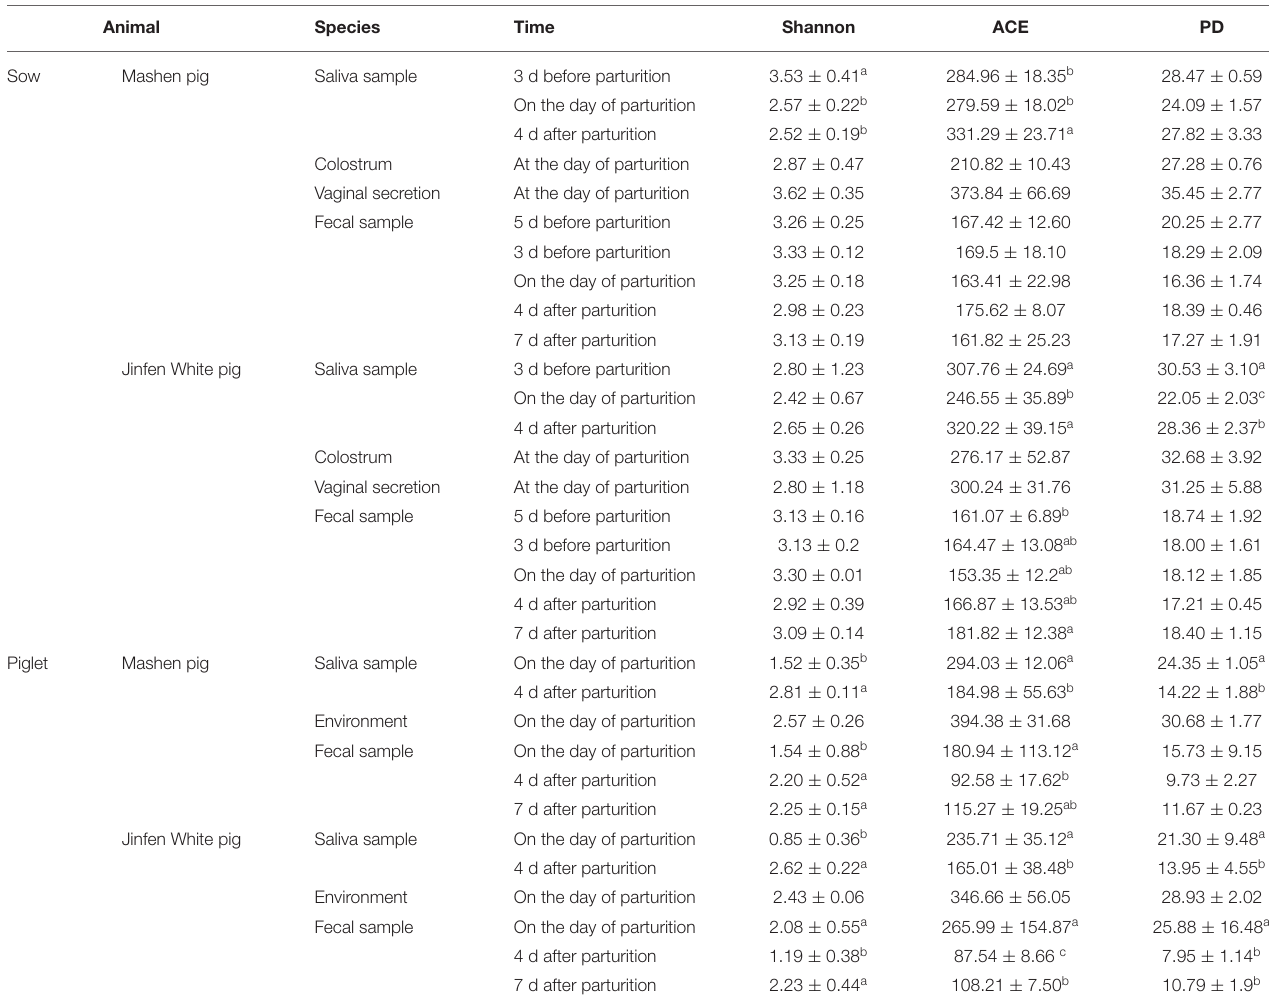
TABLE 1 | Sample microbial diversity index table of Jinfen White pig and Mashen pig. Animal Species Time Sow Mashen pig